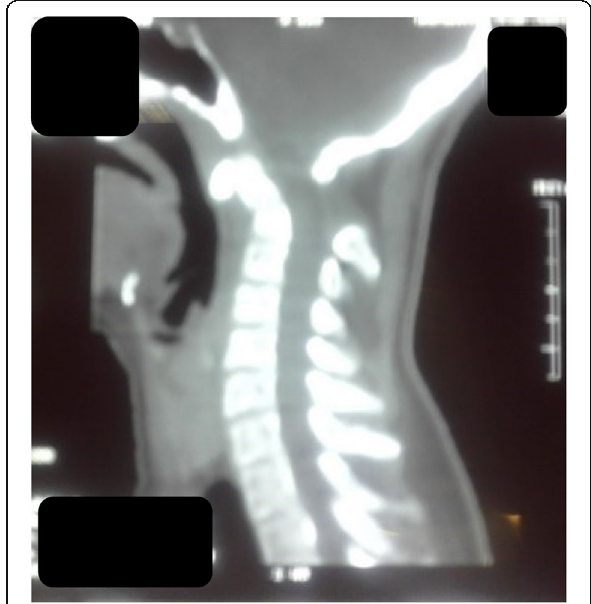
Fig. 5 Cervical CT and MRI shows odontoid fracture type